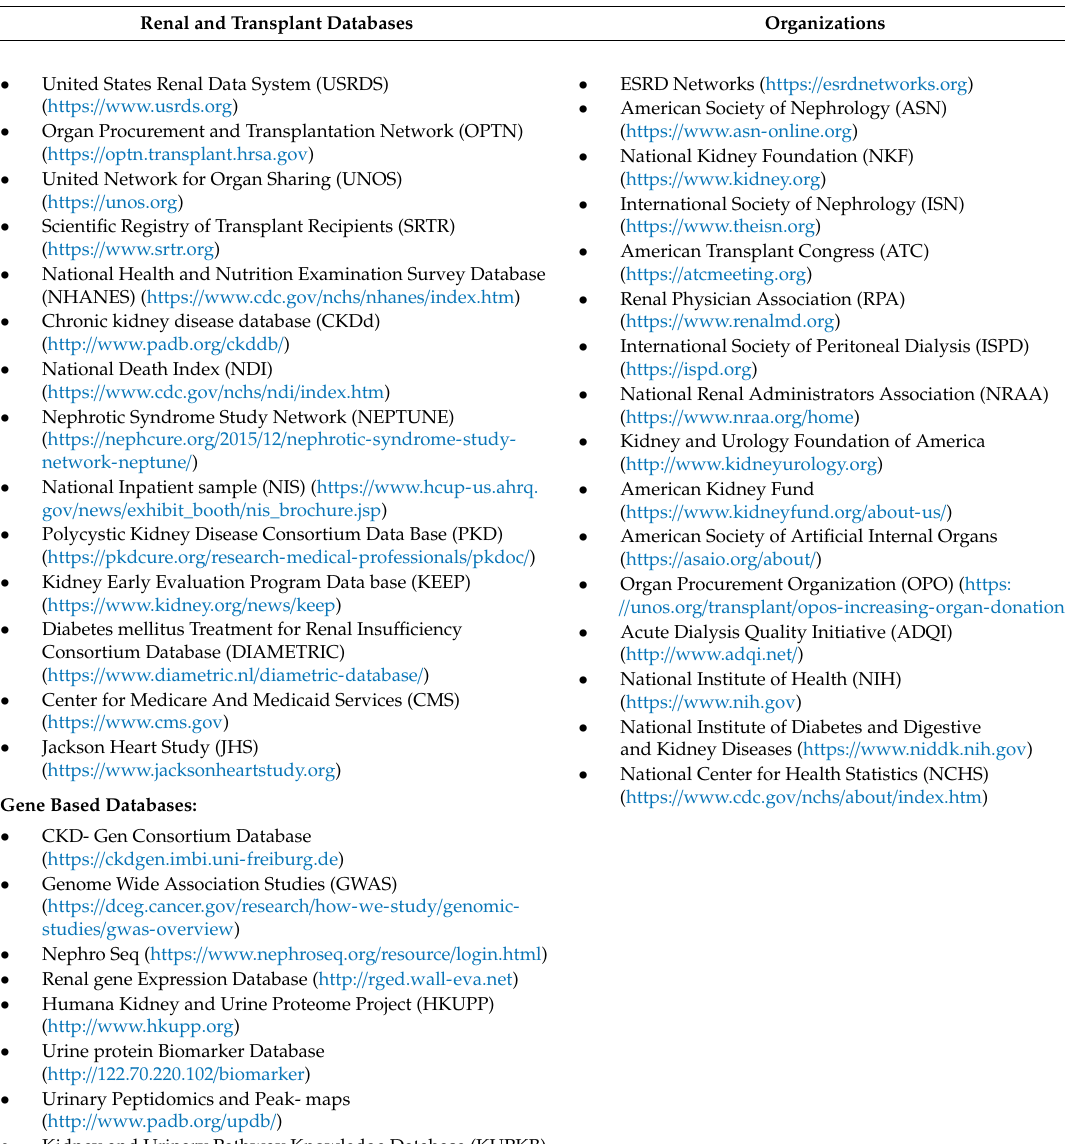
Table 1. Nephrology and transplant databases and